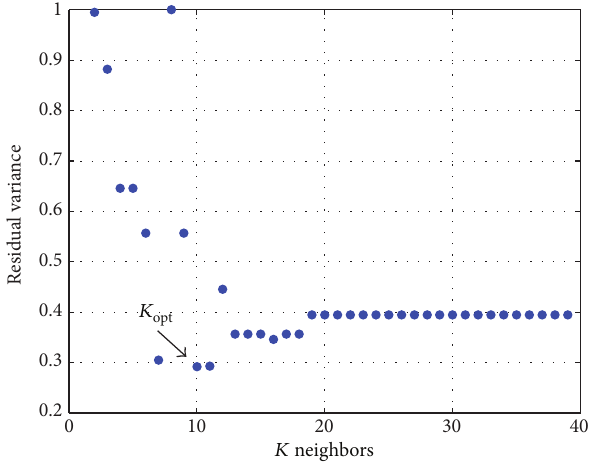
Figure 6: Finding optimal 𝐾 using residual